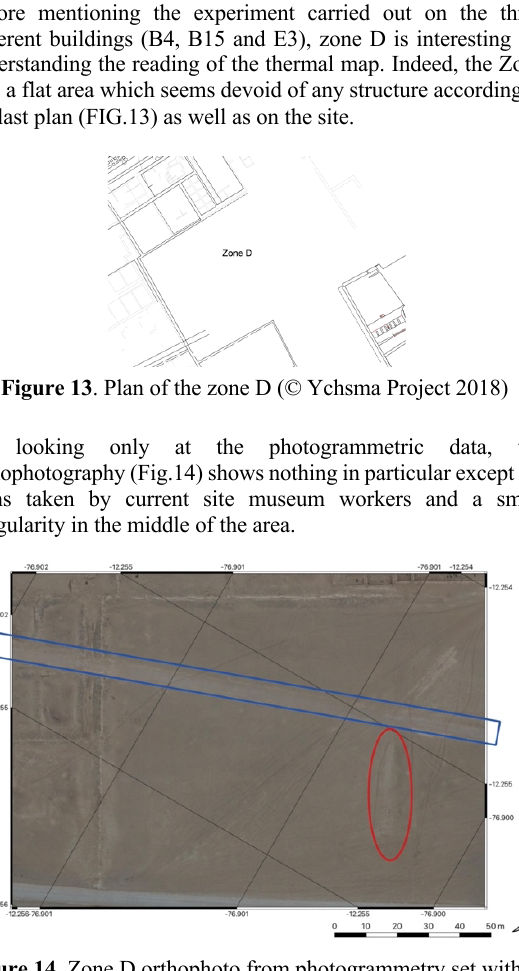
Figure 14 . Zone D orthophoto from photogrammetry set with in red a small irregularity and in blue the path of workers.